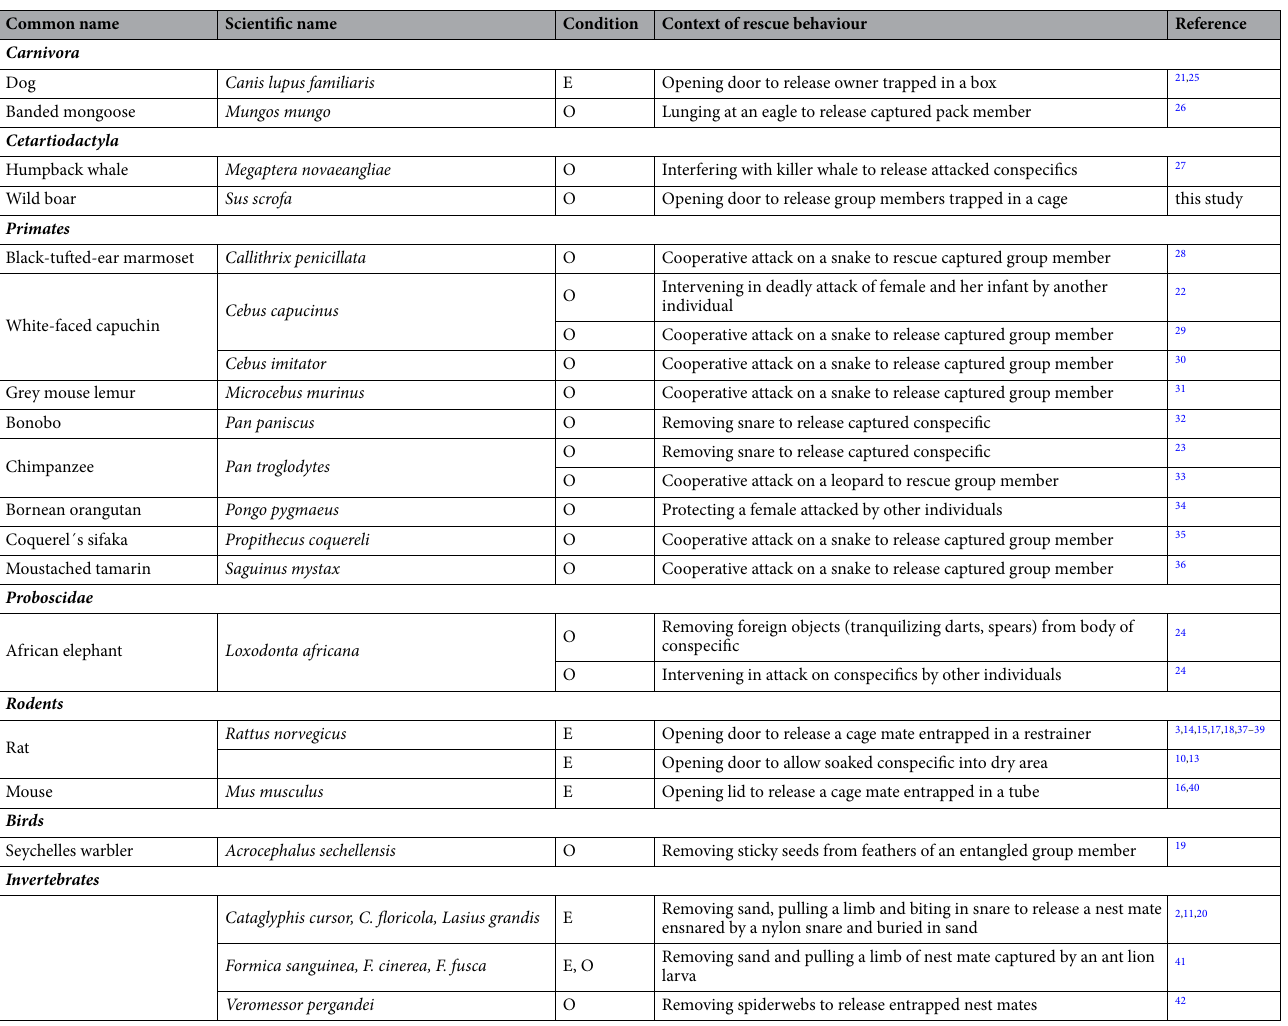
Table 1. Examples of studies documenting rescue behaviour in animals. E = experiment, O = observation. The cases involving rescue from predators are often termed as examples of cooperative self-defence against predators 19